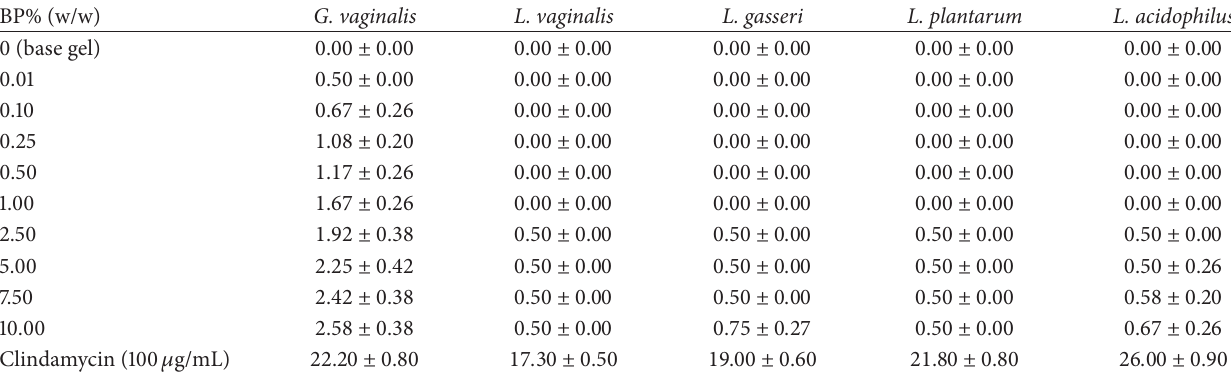
Table 1: Zones of inhibition (mm) from well diffusion assay a